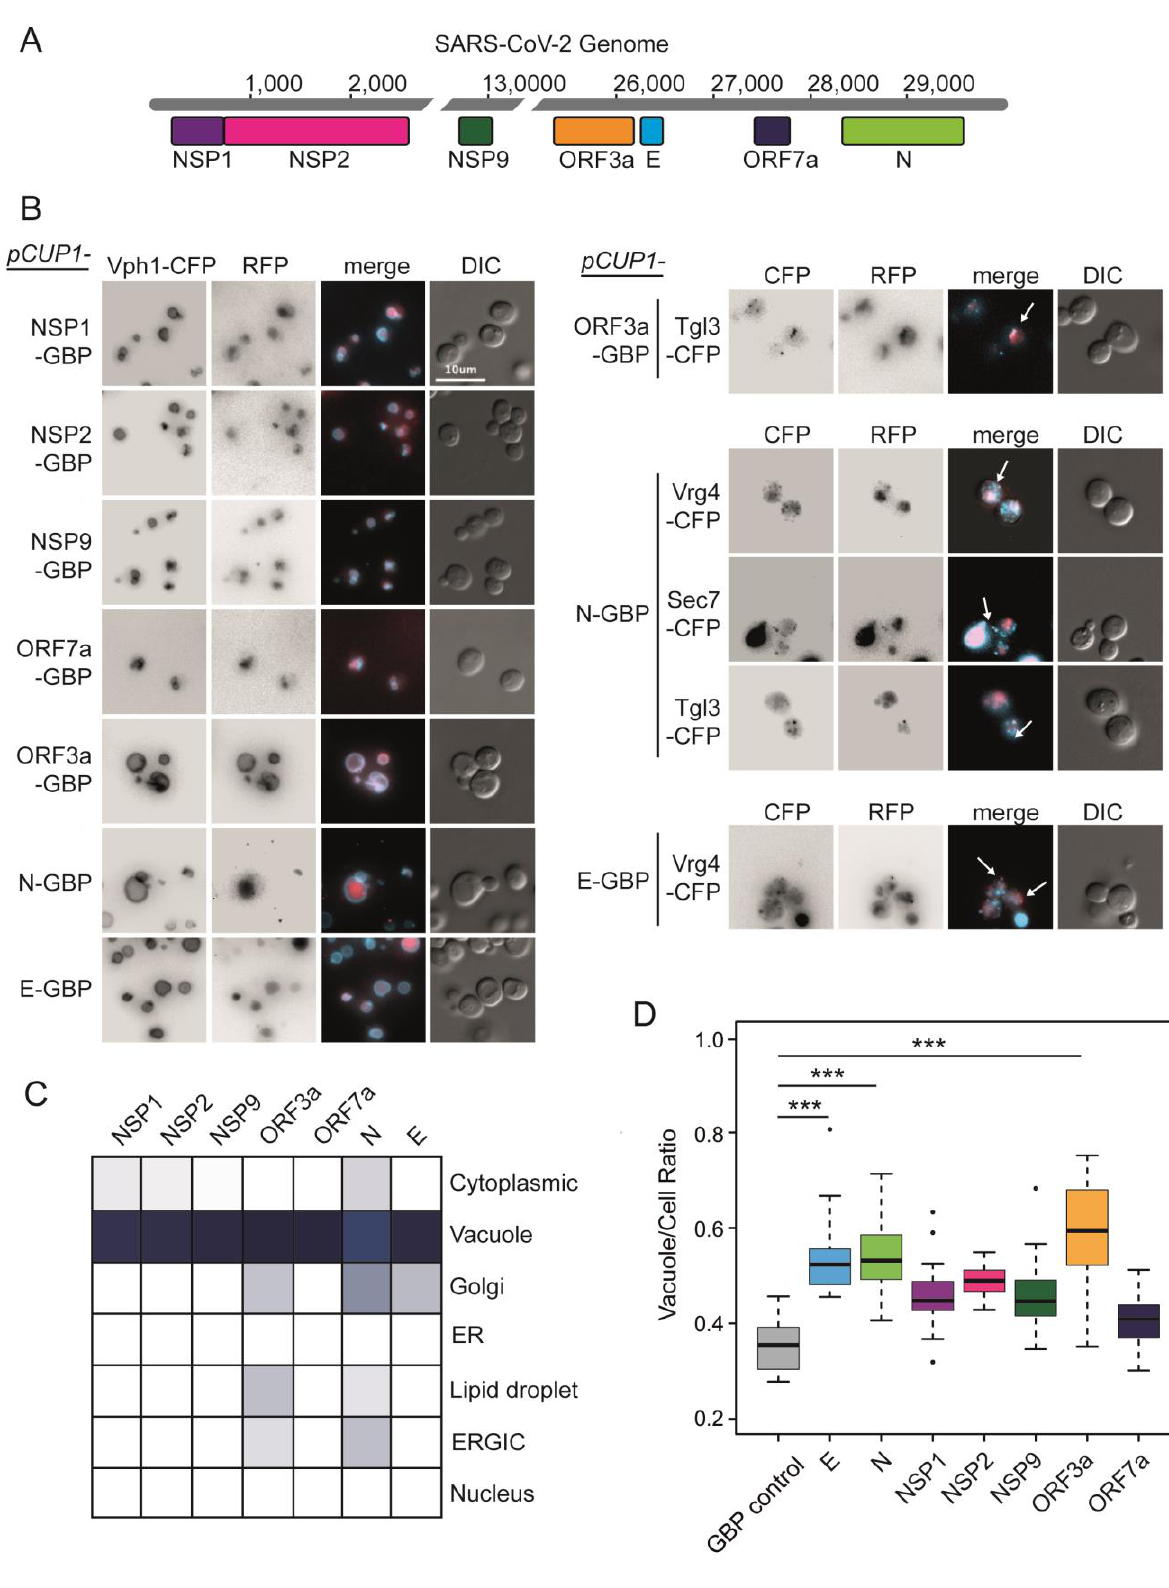
FIGURE 1: Localisation of SARS-CoV-2 proteins in yeast. (A) Seven open reading frames (ORFs) from the SARS-CoV-2 viral genome are illus- trated. These ORFs were cloned either in fusion with GBP-GFP or alone and transferred to the GFP collection of strains and growth effects measured. The viral ORF alone and GBP-RFP serve as controls. The respective colours of the seven viral proteins are consistent in data across the remaining figures. (B) Fluorescence micrographs show yeast encoding different CFP-tagged yeast proteins to evaluate cellular position